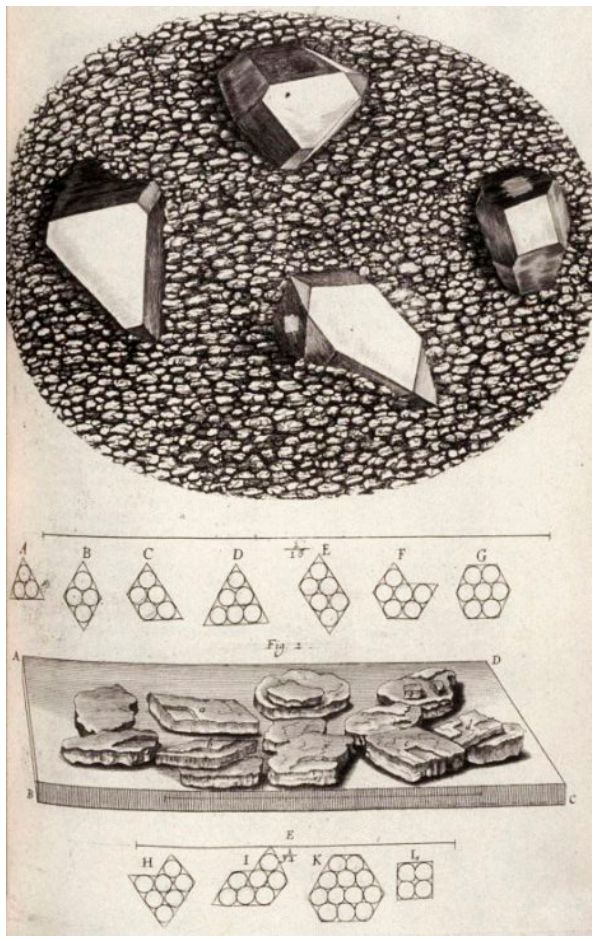
Figure 2. Morphology of the rock alum crystals related to close packing of spheres by R. Hooke. (From reference 5, opposite to page 82).